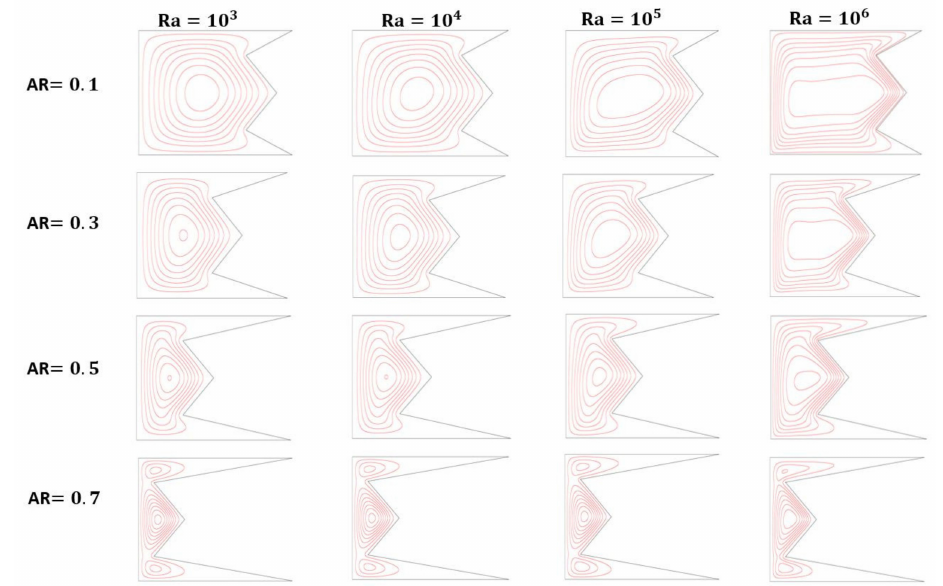
Figure 13. Streamlines for di ff erent values of aspect ratio (AR = 0.1, 0.3, 0.5 and 0.7) and Rayleigh number (Ra = 10 3 , 10 4 , 10 5 and 10 6 ) with Ha = 15, Da = 10 − 2 , ω = 0 and q ∗ =